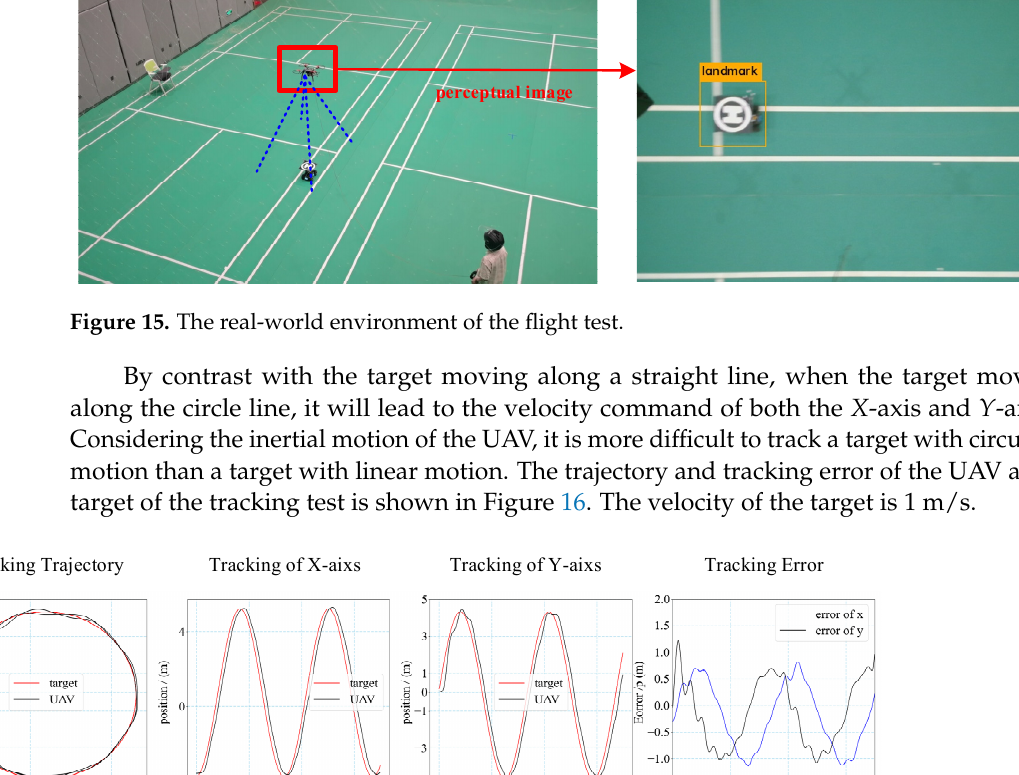
Figure 16. Trajectory and error of UAV tracking target. (The target moves along circle line at a velocity of 1 m/s).